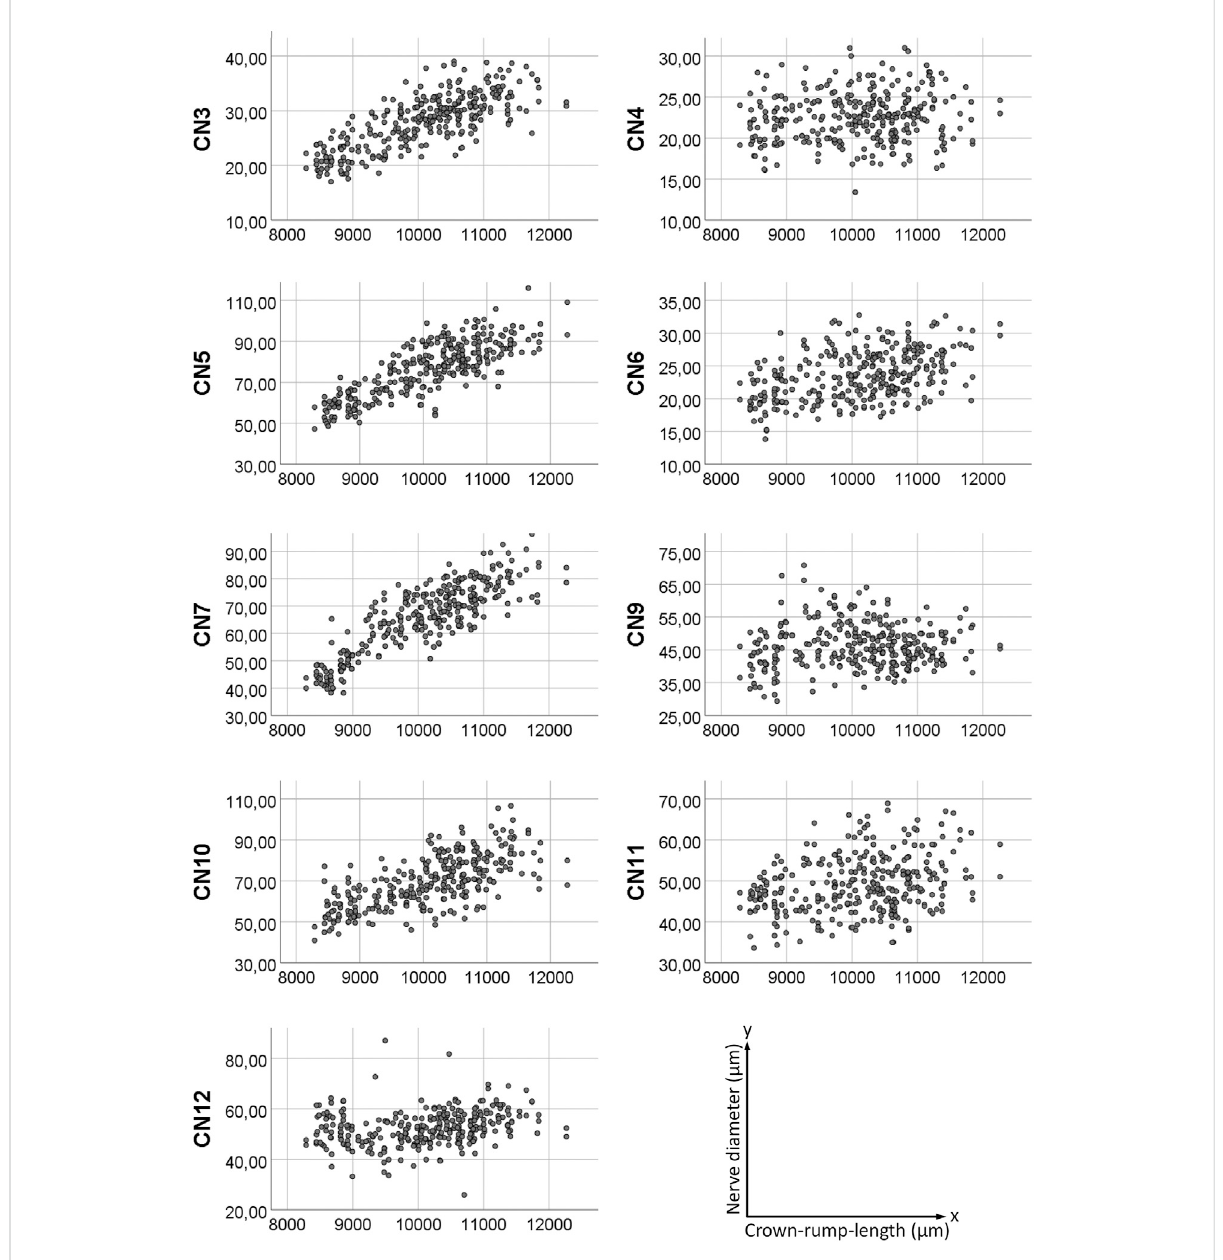
FIGURE 4 Scatter plotofmeasurednerve diameters. Y -axis showing nerve diameter inmicrometers, x -axis showing crown-rump-length inmicrometers.